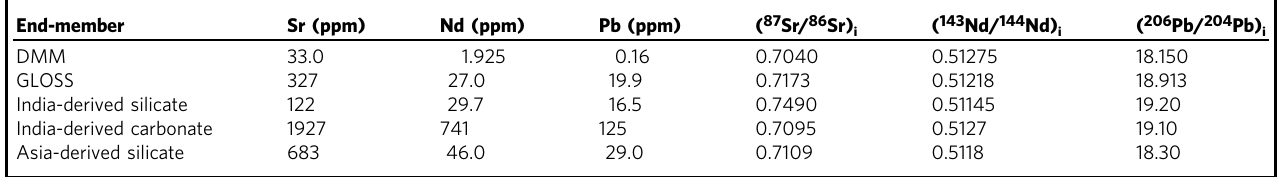
Fig. 5 A cartoon of transportation and recycling routes of carbon-rich components in Neo-Tethyan Ocean and Indian continent subduction in the Cenozoic. A: Subducting materials. B: Mantle source region of the Cenozoic magmas in Tibet. C: Collision-derived CO 2 emissions (including metamorphic and magmatic CO 2 emissions). ITS Indus-Tsangpo suture. Table 2 Compositions of the end-members in the source regions of the